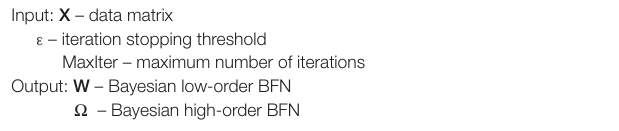
ALGORITHM 1 | Estimating BFN with BHM model.